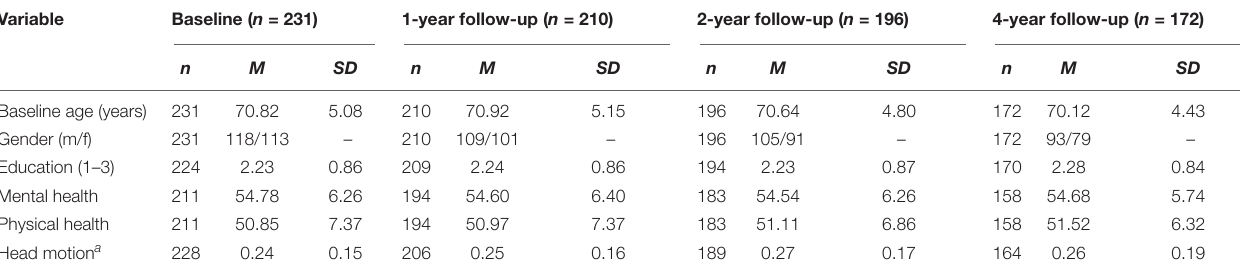
TABLE 1 | Participant characteristics of the full sample at baseline and at each follow-up wave.